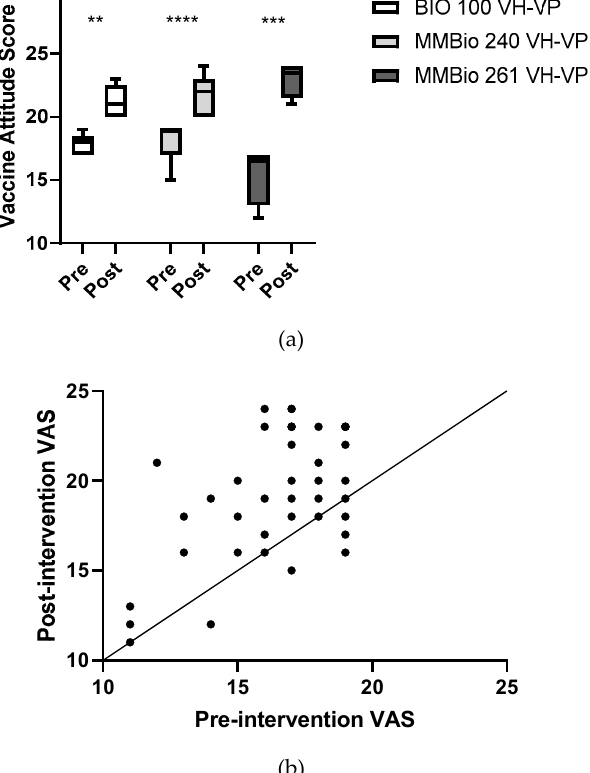
Figure 4. Vaccine-hesitant students make varying gains based on starting score and class attended. ( a ) VAS changes for VH students with PV post-intervention VASs. VH to PV students in MMBio 261 had an average VAS increase of 7.5 ± 1.0 points, whereas students in Bio 100 and MMBio 240 gained an average of 3.4 ± 1.5 and 3.5 ± 2.0 points, respectively. ( b ) VH students’ gains are determined by pre-intervention VASs. Plotting pre-intervention VASs against post-intervention VASs for VH students shows student responsiveness is dependent on pre-intervention VASs. The line indicates no change between pre-and post-intervention scores, so the farther away from the line the larger the change.